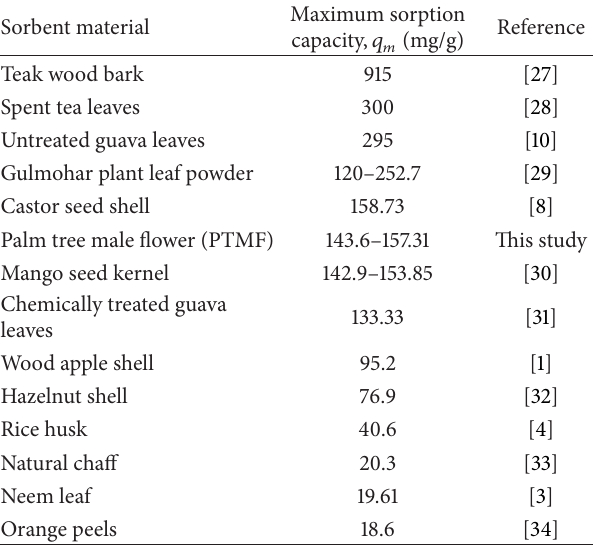
Table 4: Maximum sorption capacity of different sorbents in